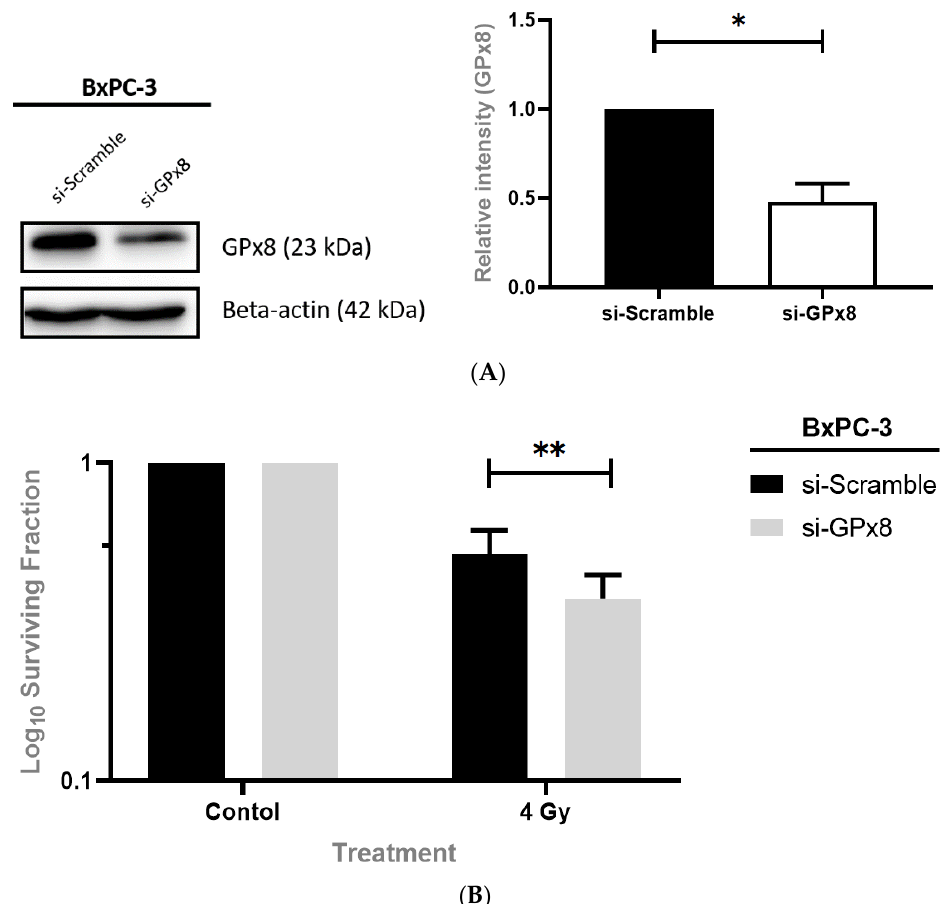
Figure 10. Silencing GPx8 in BxPC-3 cells enhances sensitivity to radiation treatment. ( A ) Repre- sentative Western blot confirming GPx8 silencing in BxPC-3 cells. BxPC-3 cells were transiently transfected with either si-Scramble or si-GPx8 for 48 h. Densitometric analysis revealed a significant reduction in GPx8 expression (* p = 0.0434) in si-GPx8 cells compared to si-Scramble cells. Data are presented as the mean ± SEM and analyzed by a one-sample t -test ( n = 4). ( B ) Clonogenic analysis revealed that silencing GPx8 in BxPC-3 cells significantly reduced the surviving fraction (** p = 0.00353) when compared to its scrambled control. All cells were irradiated with 4 Gy whilst controls were mock-irradiated (0 Gy) 48 h post-transfection. Data are expressed as the mean ±